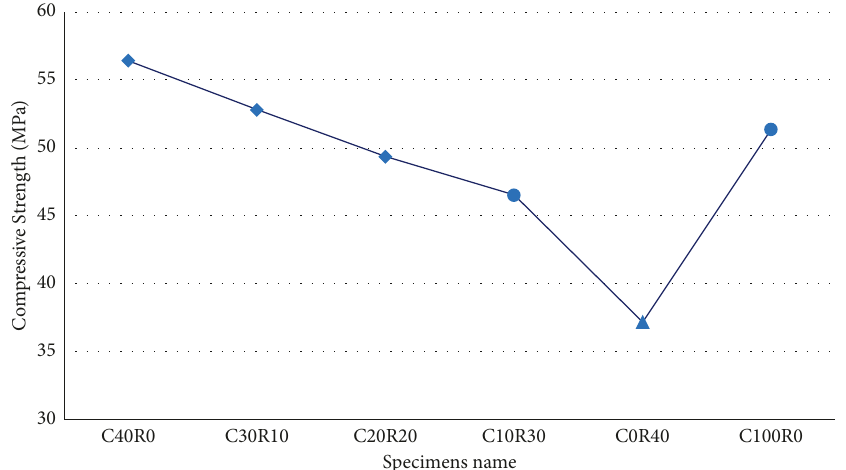
Figure 5: Comparison of compressive